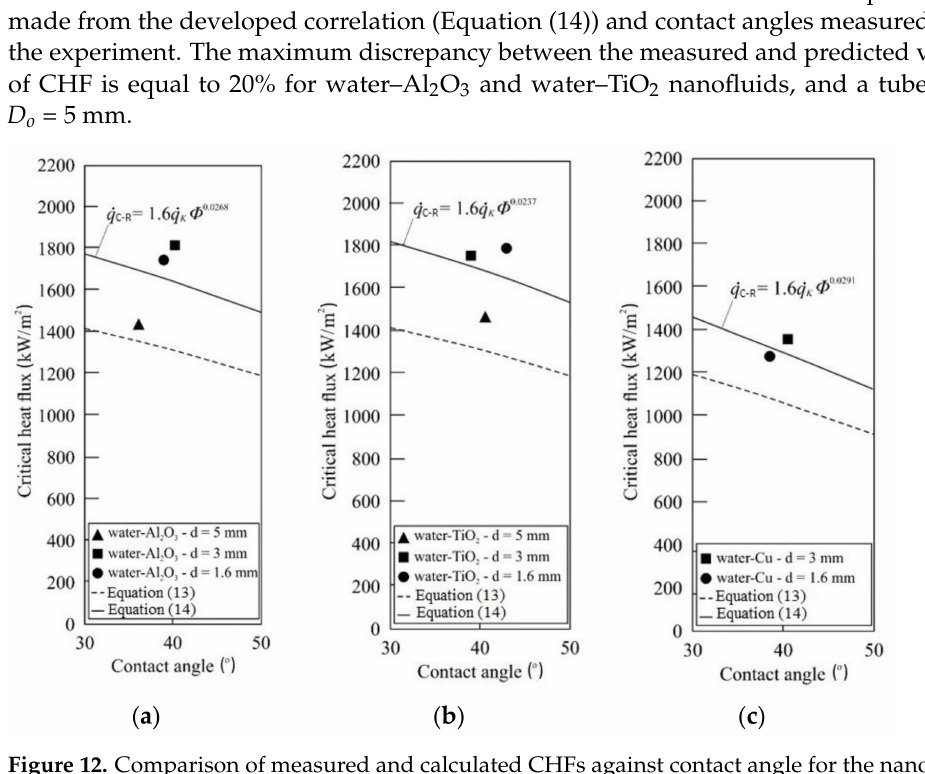
Figure 12. Comparison of measured and calculated CHFs against contact angle for the nanofluids tested: ( a ) water–Al 2 O 3 , ( b ) water–TiO 2 , ( c )